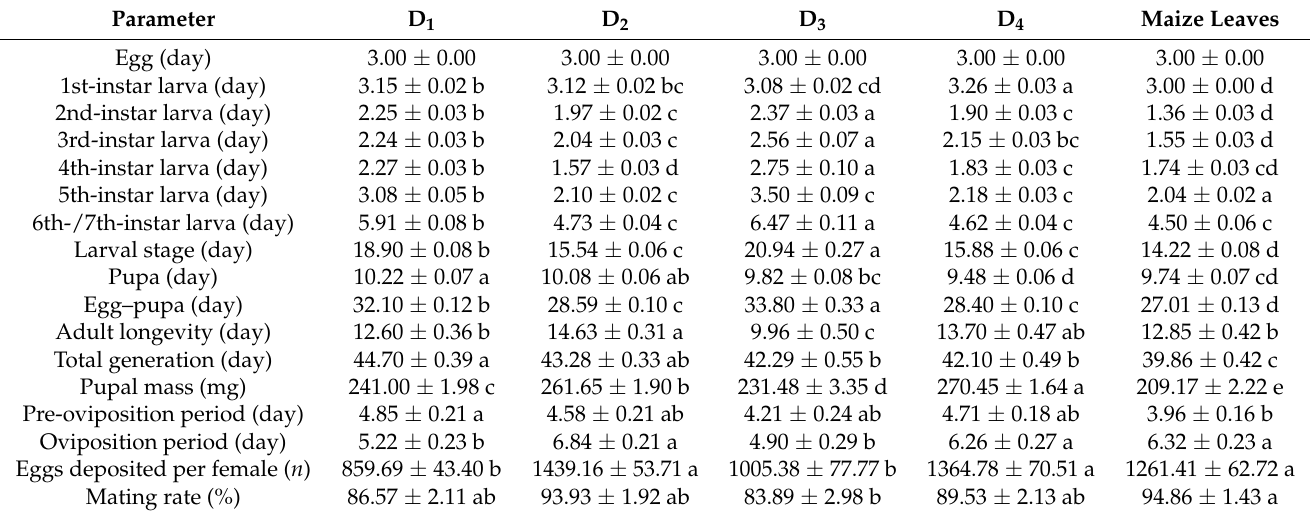
Table 2. Mean duration and reproductive performance ( ± SE) of developmental stages of FAWs ( Spodoptera frugiperda ) fed different diets.